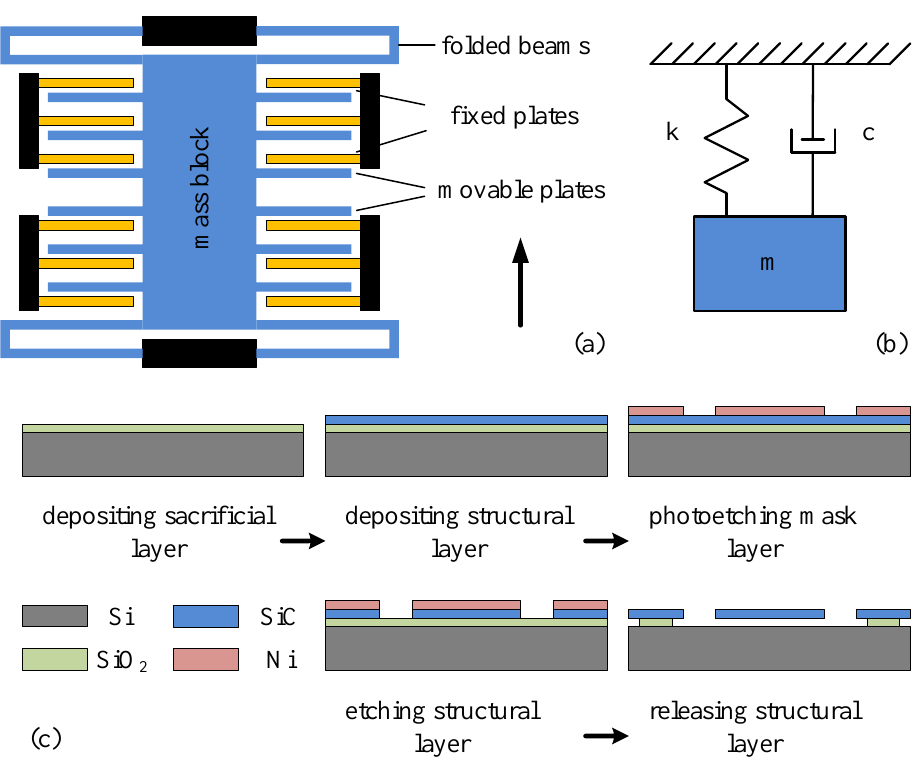
Figure 1. Model of a single-axis, comb-type capacitive micro accelerometer. ( a ) Physical model of the accelerometer, ( b ) mechanical model of the accelerometer, ( c ) process flow of the accelerometer.